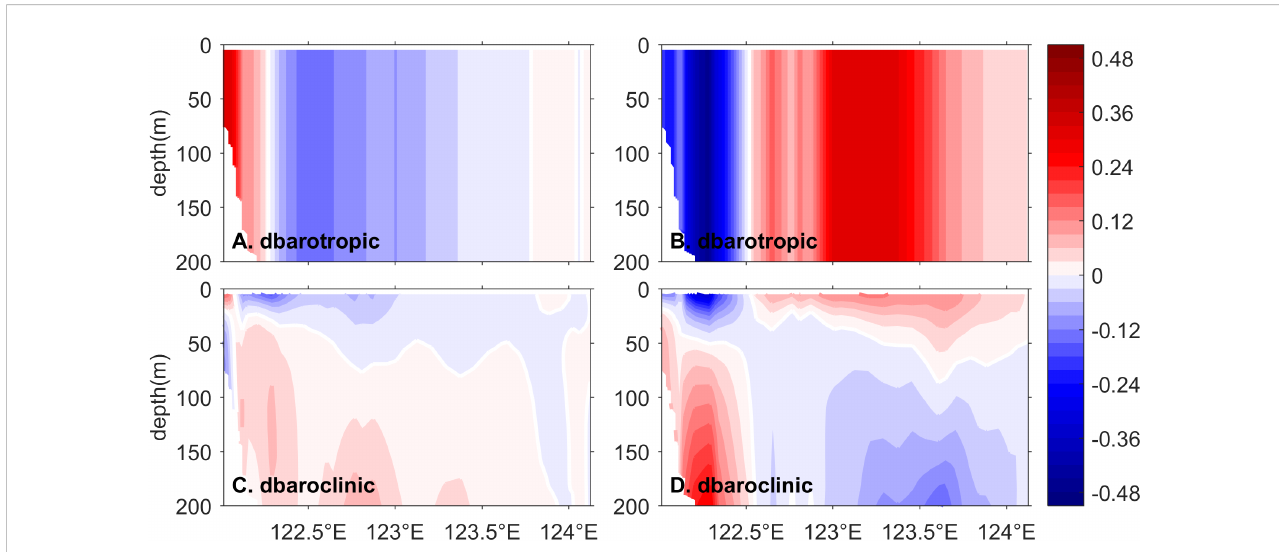
FIGURE 9 The decomposition of the variation in the pressure gradient contribution term (m/s) along the 200 m isobaths at t=30 days under the in fl uence of (A, C) cyclonic and (B, D) anticyclonic